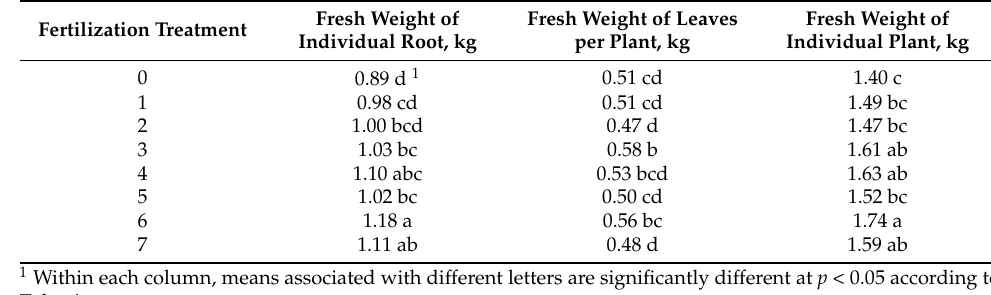
Table 4. Morphological features of sugar beet (means from 2018 to 2020).